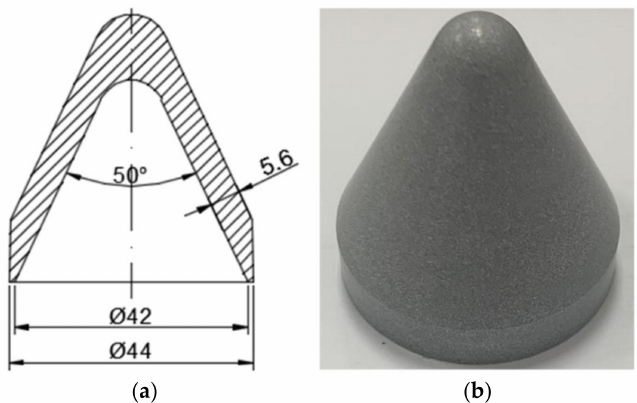
Figure 8. Structure and specimen of the PTFE / Al reactive liner: ( a ) structure; ( b ) liner specimen.